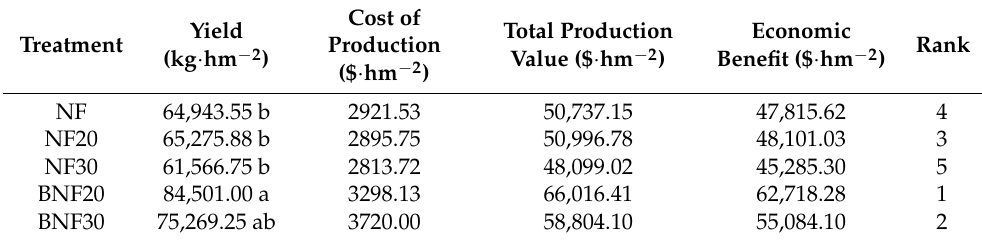
Table 5. Effects of different fertilization treatments on economic benefit of ‘yellow rose’